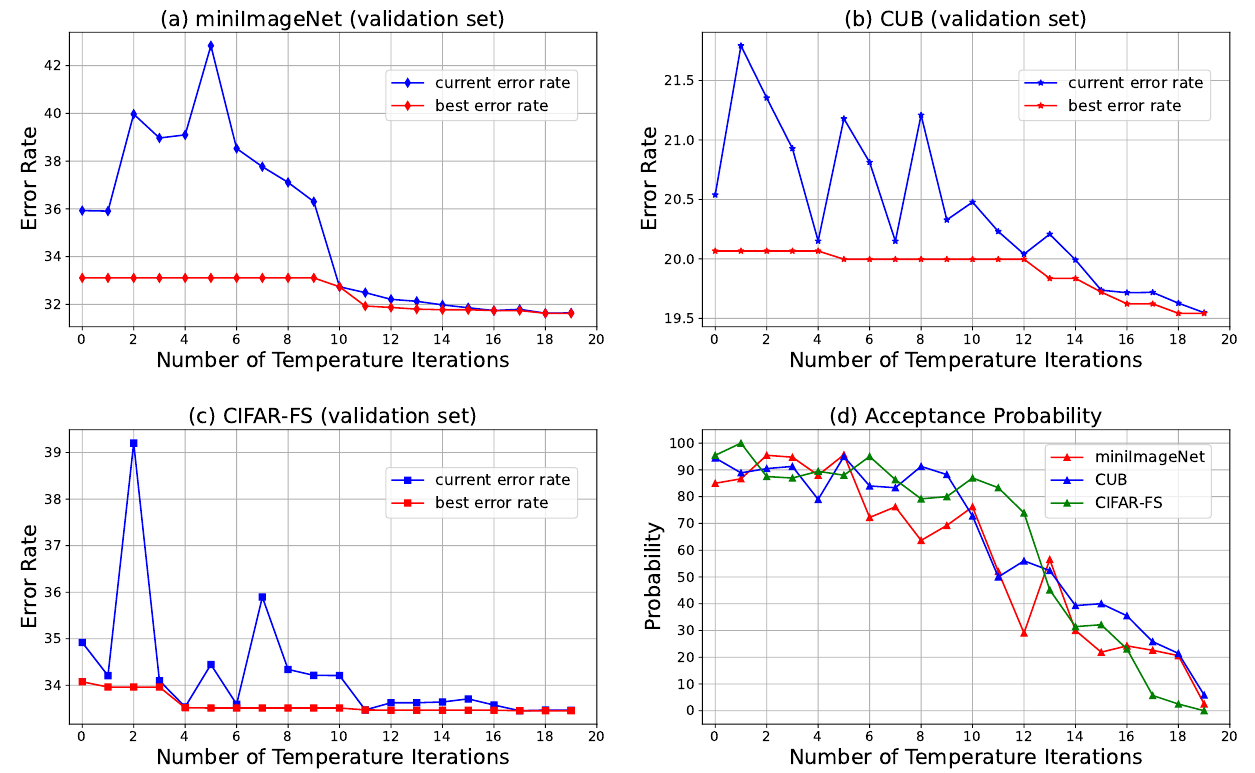
Figure 5. Visualization of the error rate and acceptance probability on validation sets of mini ImageNet, CUB-200-2011, and CIFAR-FS. ( a ) The variation of the model error rate on the validation set of mini ImageNet as the temperature iterations increase. ( b ) The variation of the model error rate on the validation set of CUB-200-2011 as the temperature iterations increase. ( c ) The variation of the model error rate on the validation set of CIFAR-FS as the temperature iterations increase. ( d ) The variation of acceptance probability on three datasets as the number of temperature iterations